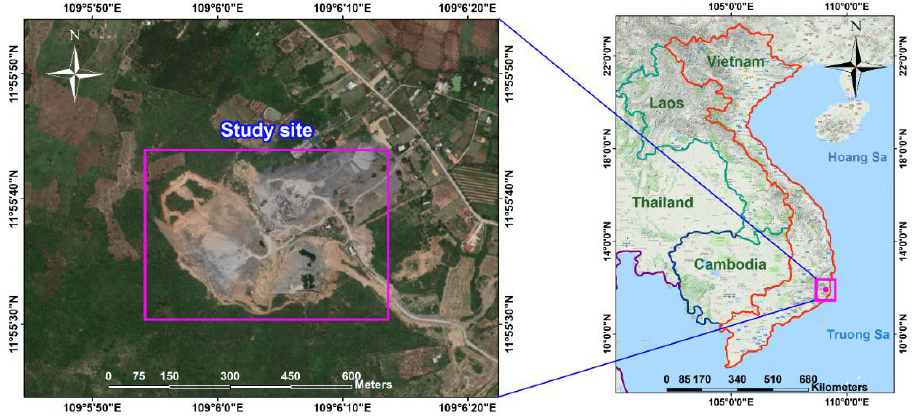
Figure 1. Location and overview of the study site.